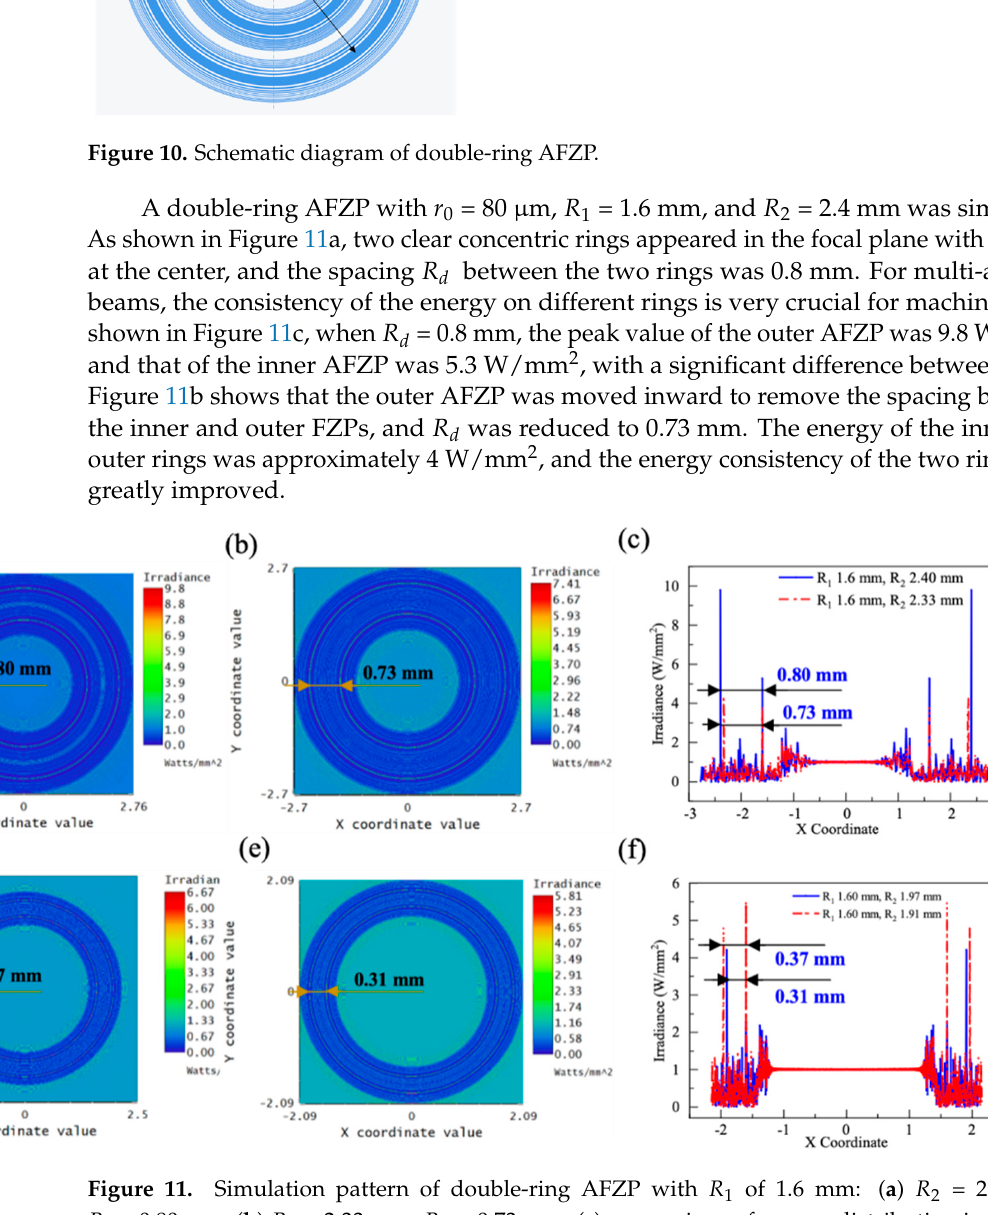
Figure 11. Simulation pattern of double-ring AFZP with 𝑅 (cid:2869) of 1.6 mm: ( a ) 𝑅 (cid:2870) = 2.40 mm, 𝑅 (cid:3031) = 0.80 mm; ( b ) 𝑅 (cid:2870) = 2.33 mm, 𝑅 (cid:3031) = 0.73 mm; ( c ) comparison of energy distribution in a/b diagram; ( d ) 𝑅 (cid:2870) = 1.97 mm, 𝑅 (cid:3031) = 0.37 mm; ( e ) deletion of 12 zones, with 𝑅 (cid:2870) = 1.91 mm, 𝑅 (cid:3031) = 0.31 mm; ( f ) comparison diagram of energy distribution of d/e